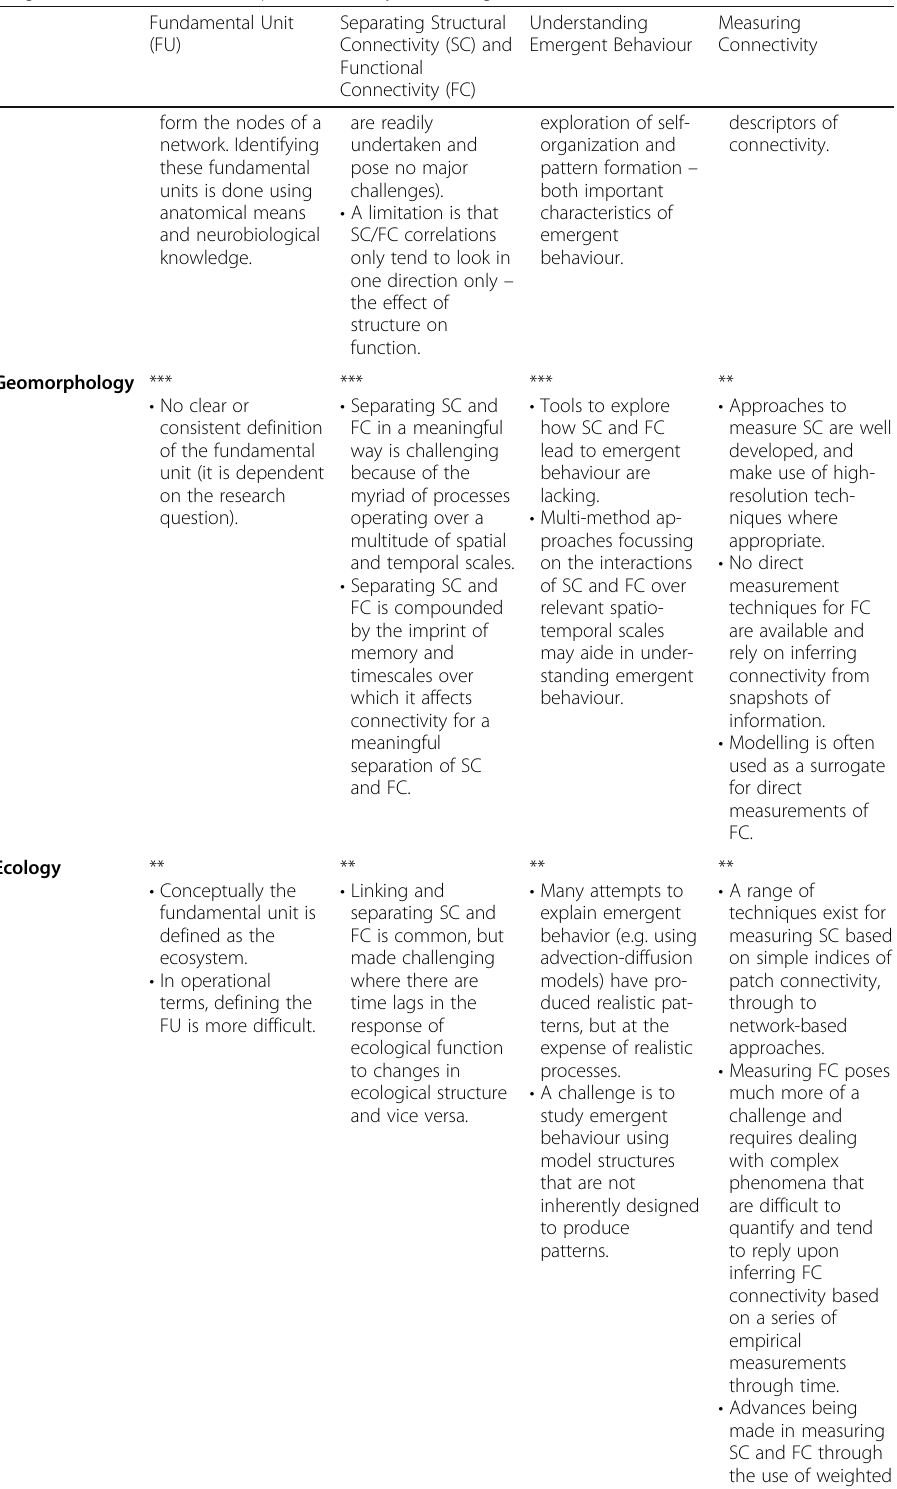
Table 1 Summary of connectivity challenges across different disciplines. Extent to which connectivity challenges are an issue: * do not present a challenge; ** presents a challenge but progress has been made; *** presents a major challenge.